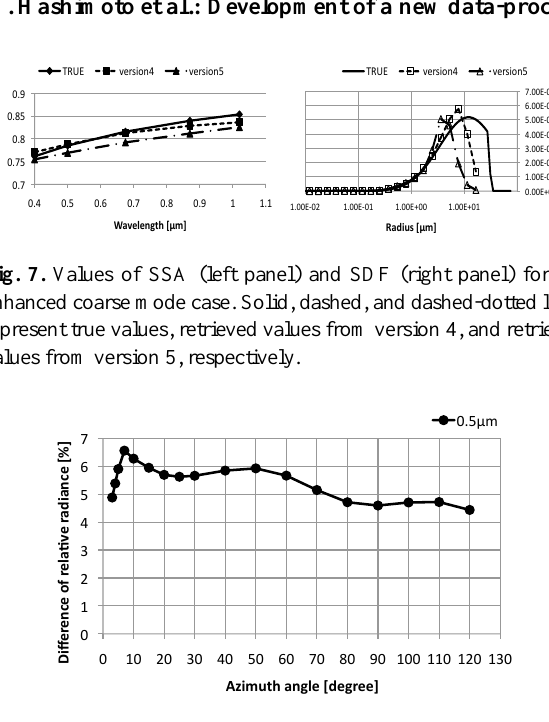
Fig. 8. The percentage difference of the relative radiances at 0.5µm for each scattering angle between SDFs with and without particles over 10µm in radius.